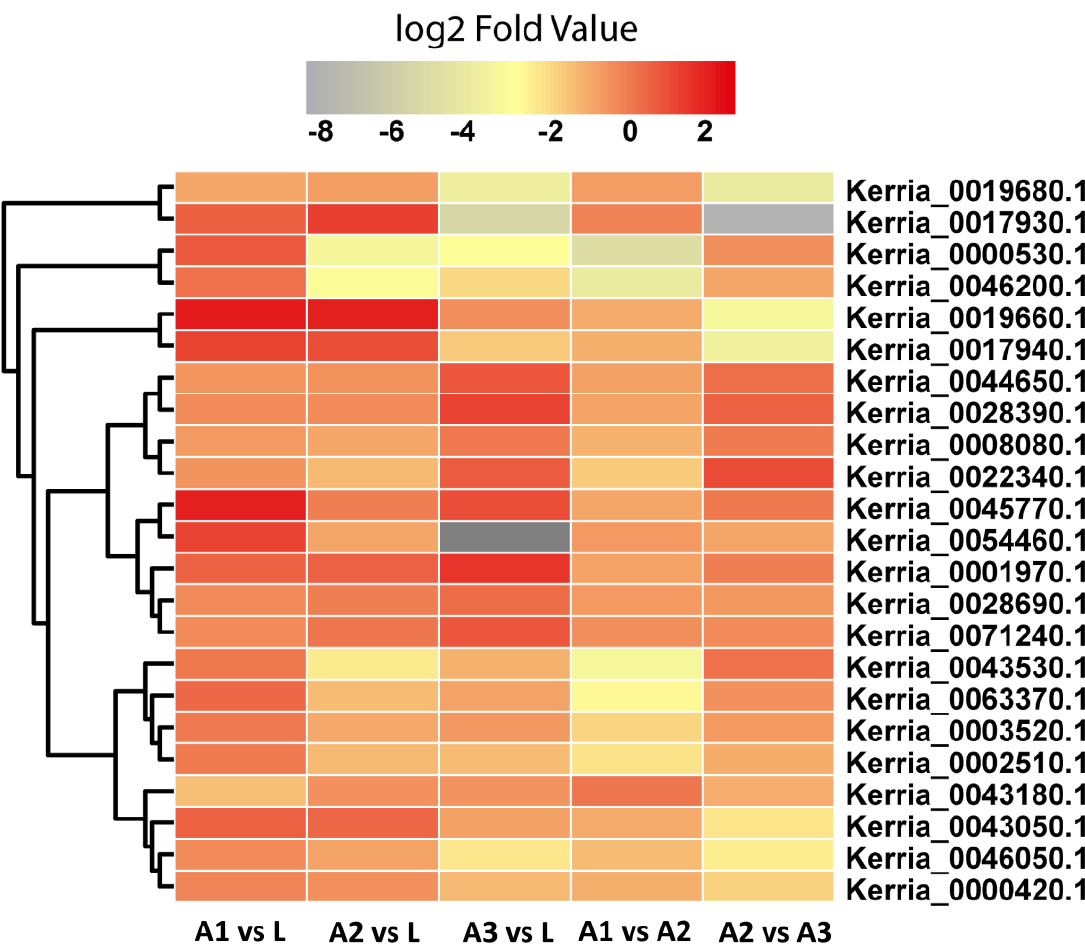
Figure 5. Heatmap of expression profiles of 23 SNPs at different developmental stages of K. lacca .